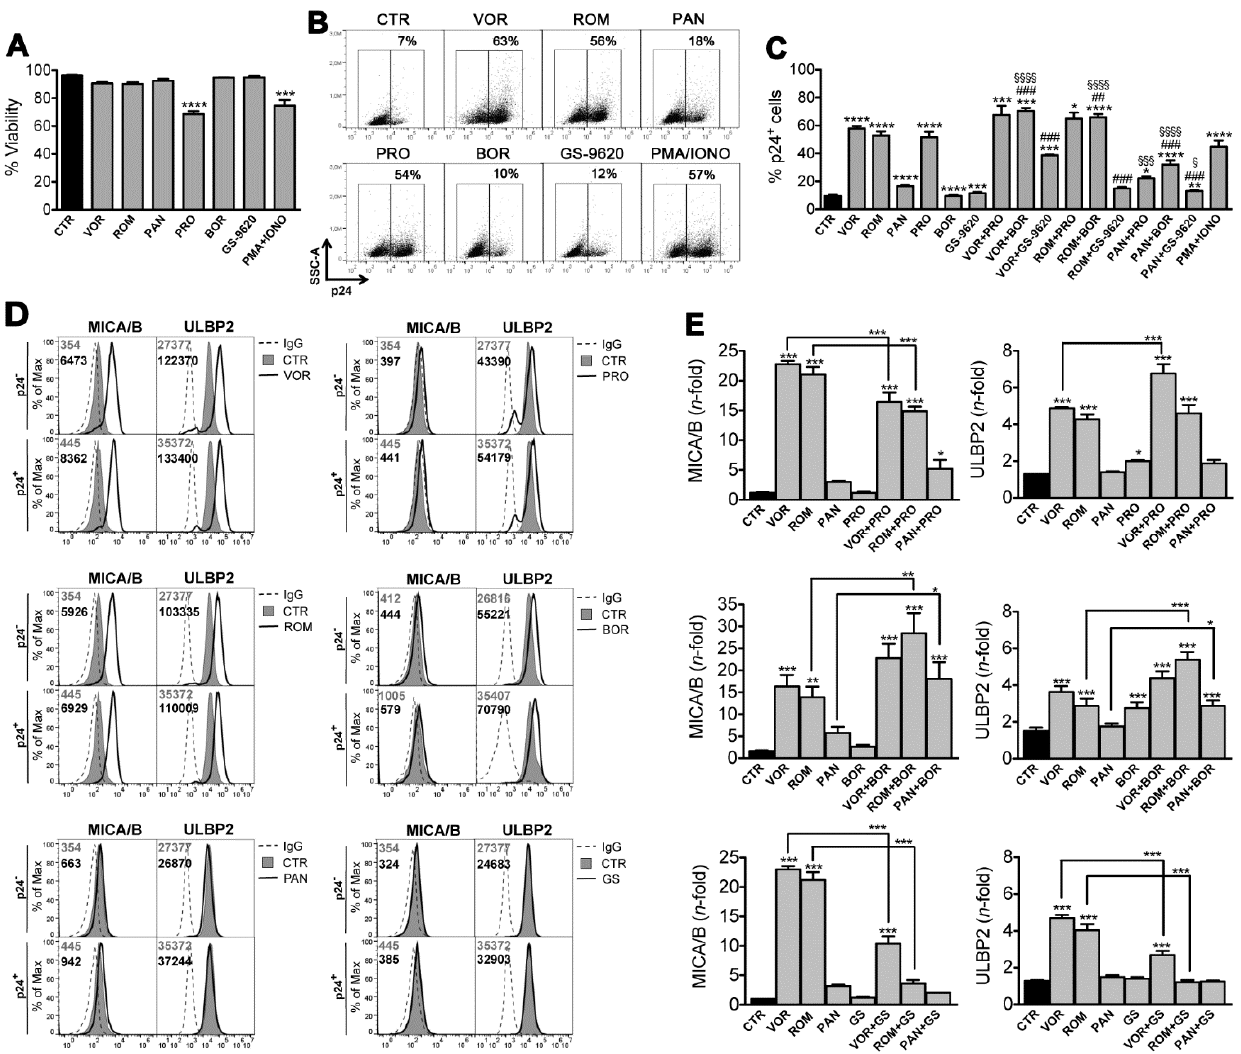
Figure 1. HIV-1 reactivation and modulation of NKG2DLs expression by two-drug combinations in J1.1 cells. J1.1 cells were treated for 48 h with solvent as control (CTR), 100 ng/mL PMA plus 1 µg/mL Ionomycin (PMA/IONO) as maximal stimulation, 10 µM VOR, 20 nM ROM, 20 nM PAN, 1 µM PRO, 5 nM BOR, or 3 µM GS-9620 used alone or combining each HDACi (VOR, ROM, PAN) with PRO, BOR, or GS-9620. Then, cells were analyzed for cell viability, HIV-1 reactivation (i.e., intracellular p24 expression) and cell-surface MICA/B and ULBP2 expression by multicolor flow cytometry. ( A ) The viability of treated J1.1 cells was examined by LIVE/DEAD staining and expressed relatively to CTR samples set at 100%. Bars represent mean ± SEM ( n = 11). *** p < 0.001, **** p < 0.0001 by paired t -test. ( B ) Representative dot plots show the frequency of p24 + J1.1 cells with reactivated HIV following single treatments. ( C ) HIV reactivation quantified as %p24 + cells was determined in 11 independent experiments (mean ± SEM). Statistics was performed using paired t -test; versus control (CTR): * p < 0.05, ** p < 0.01, *** p < 0.001, **** p < 0.0001; versus HDACi alone: ## p < 0.01, ### p < 0.001; versus 2nd LRA alone: § p < 0.05, §§§ p < 0.001, §§§§ p < 0.0001. ( D ) Histograms show MICA/B and ULBP2 fluorescence in gated p24 - and p24 + cells in a representative experiment with J1.1 cells following the indicated treatments. Filled gray and open histograms represent staining of CTR and treated cells, respectively. Signal obtained with control IgG (dashed line) and mean fluorescence intensity (MFI) values for CTR (gray) and treated (black) cells are indicated. ( E ) Quantification of MICA/B (left panels) and ULBP2 (right panels) up-modulation induced by single or 2-drug combination on p24 + cells relative to p24 - CTR cells. Bars represent mean ± SEM ( n = 7). Statistics was performed using One-way Anova with Bonferroni post test to perform multiple comparisons; significant differences versus control (CTR) and versus HDACi alone are indicated: * p < 0.05, ** p < 0.01, *** p <